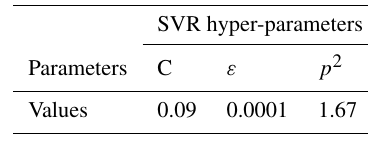
Table 3. Values for the regularization constant C, decided by Eq.(9); the width of the insensitive zone ε , decided by Eq.(10); and the BRF kernel parameter p 2 , decided by hyper-parameter